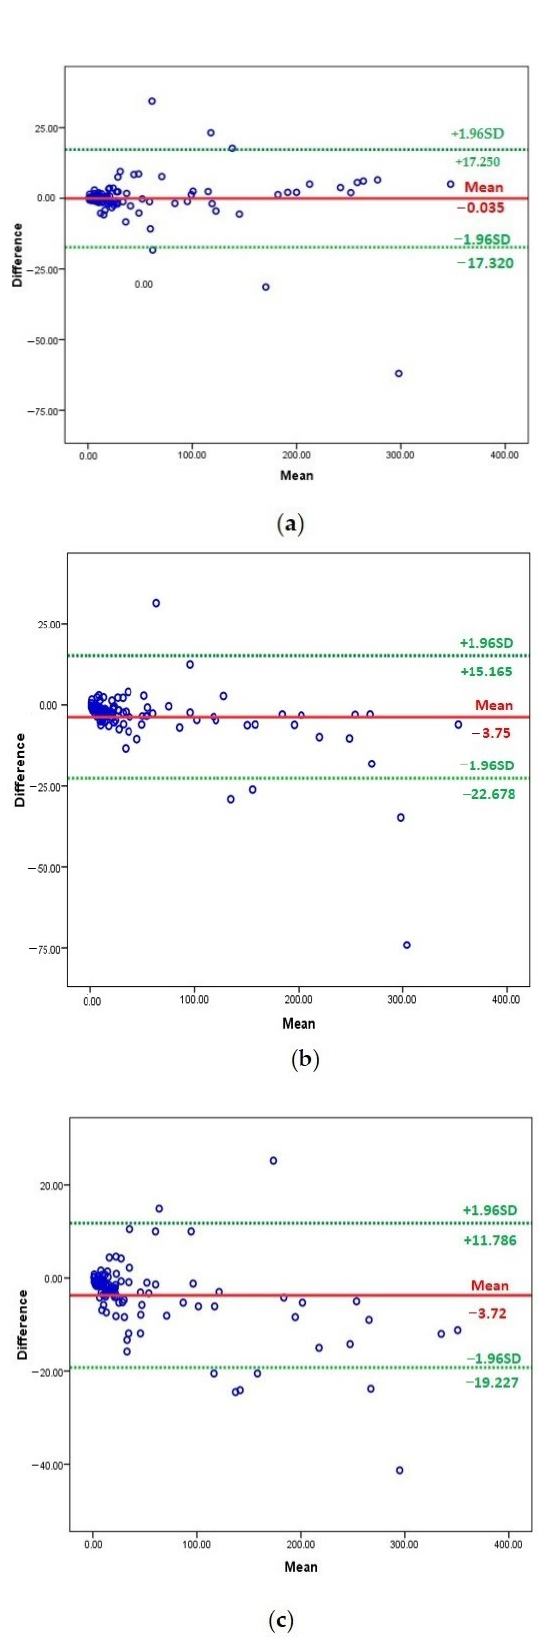
Figure 2. ( a ) Association between ELISA and Cobas e411 methods using Bland–Altman plot analysis; ( b ) association between ELISA and Cobas Integra 400 methods using Bland–Altman plot analysis; ( c ) association between Cobas e411 and Cobas e411 methods using Bland–Altman plot analysis. Table 5. Bias, limits of agreement, and correlation coefficients of methods.